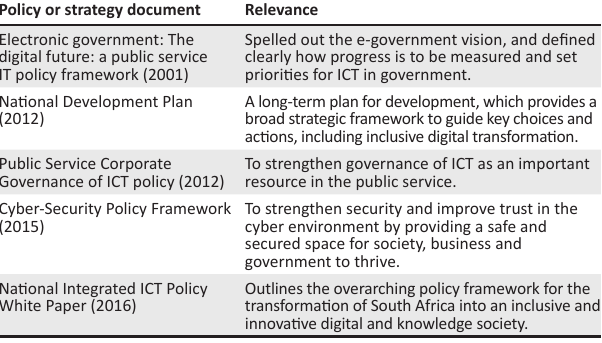
TABLE 1: Main policies influencing digital transformation in South